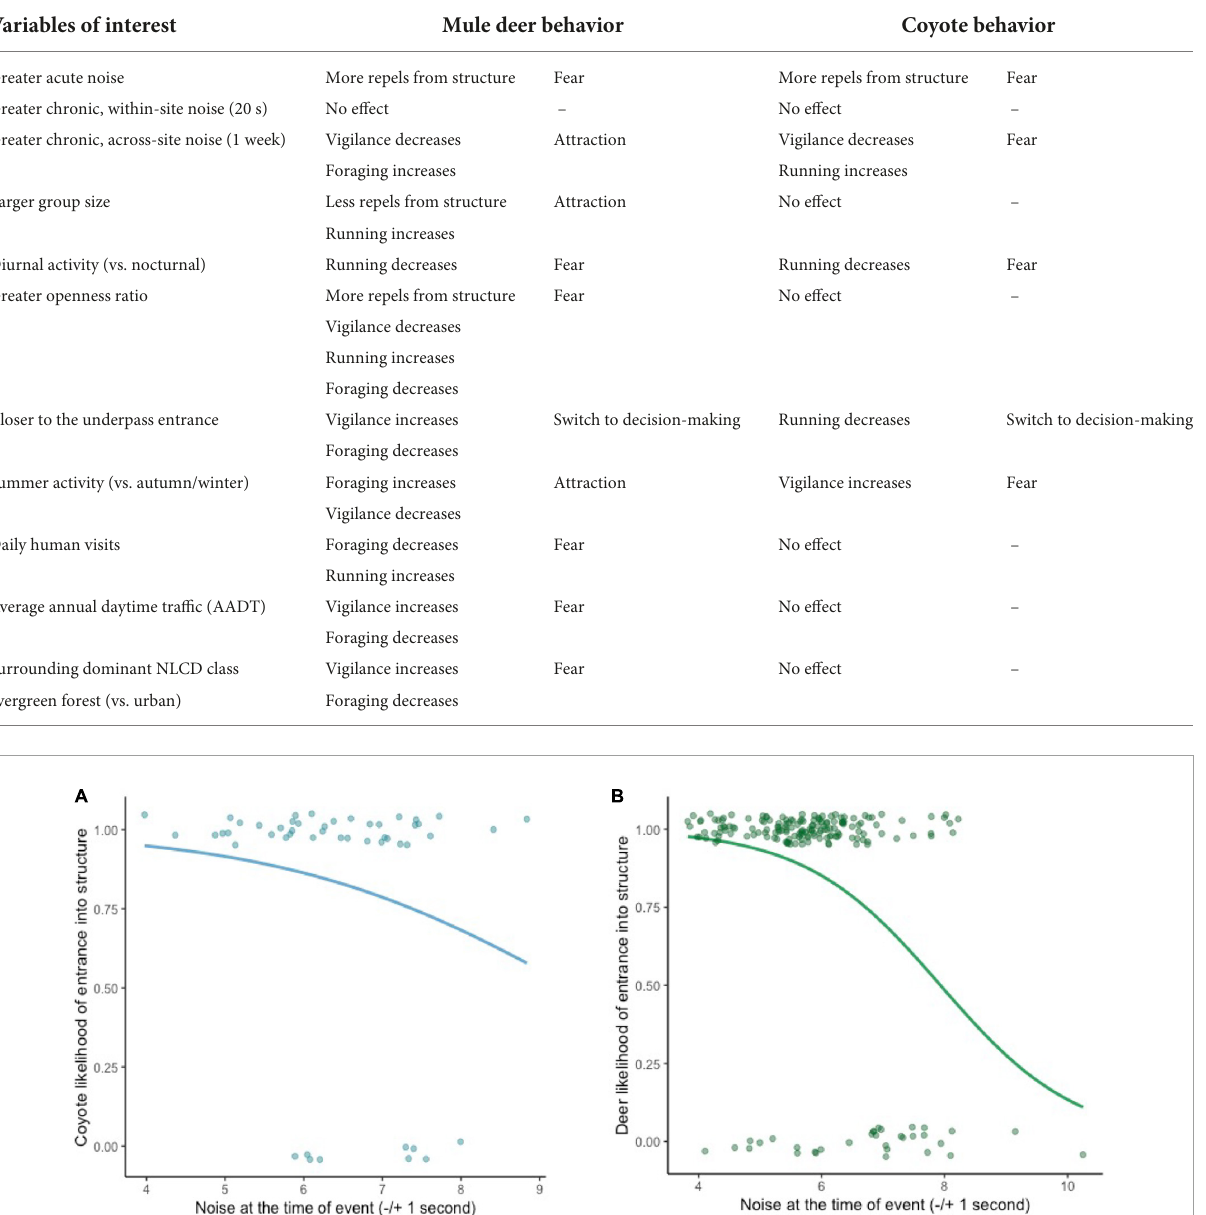
TABLE 1 A summary of the continuous response variables examined and their effects on coyote and mule deer flight response, vigilance, foraging, and running (mule deer only) behavior.